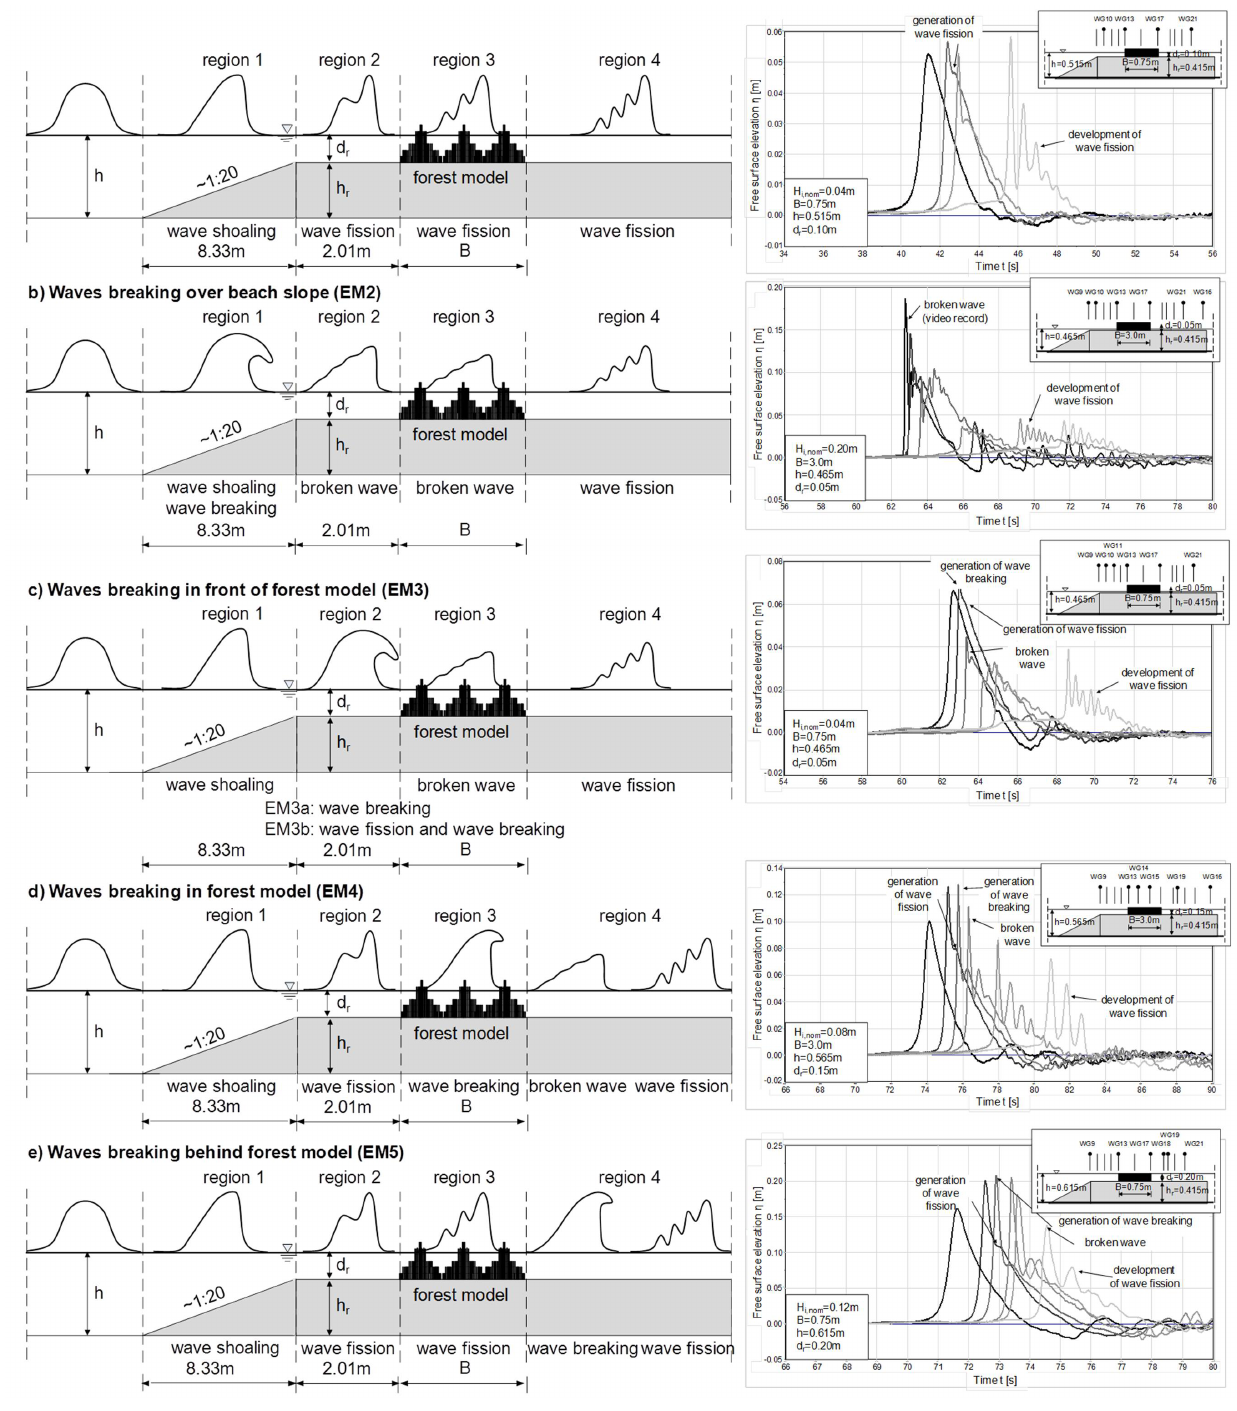
Fig. 7. Observed modes of solitary wave evolution in the foreshore and in the mangrove forest for different forest widths B , incident wave heights H i,nom and water depths h and d r in the far field and just in front of the forest,